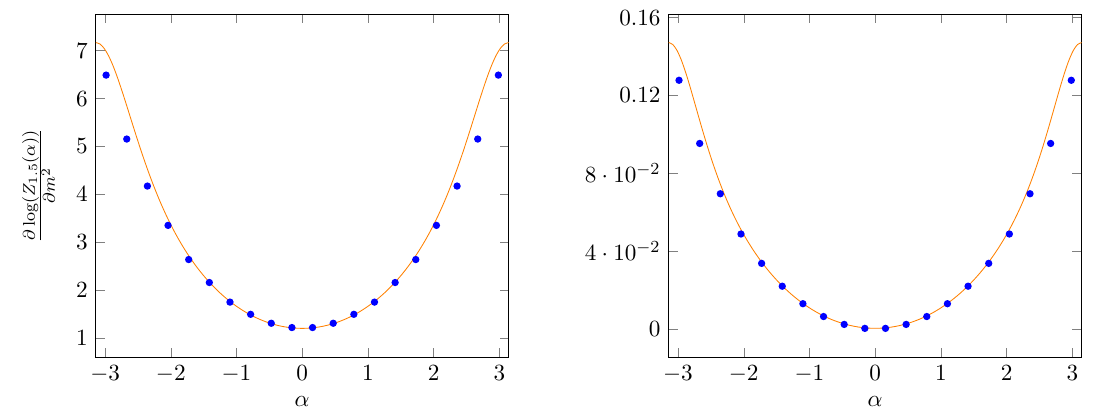
( α )) computed at β = 5 n